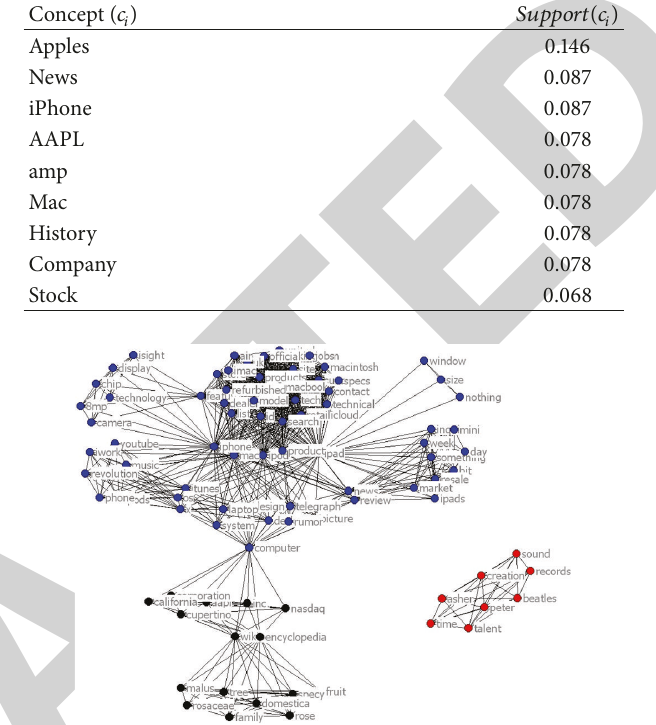
Figure 1: A snippet of the query “apple” provided by Google .